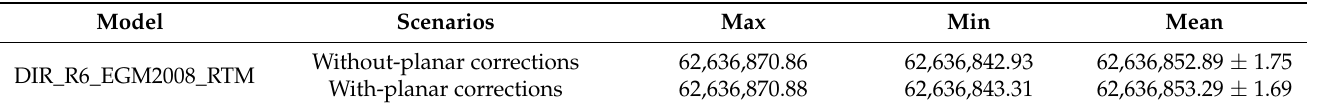
Table 5. Statistics of the without-planar corrections and with-planar corrections scenarios for